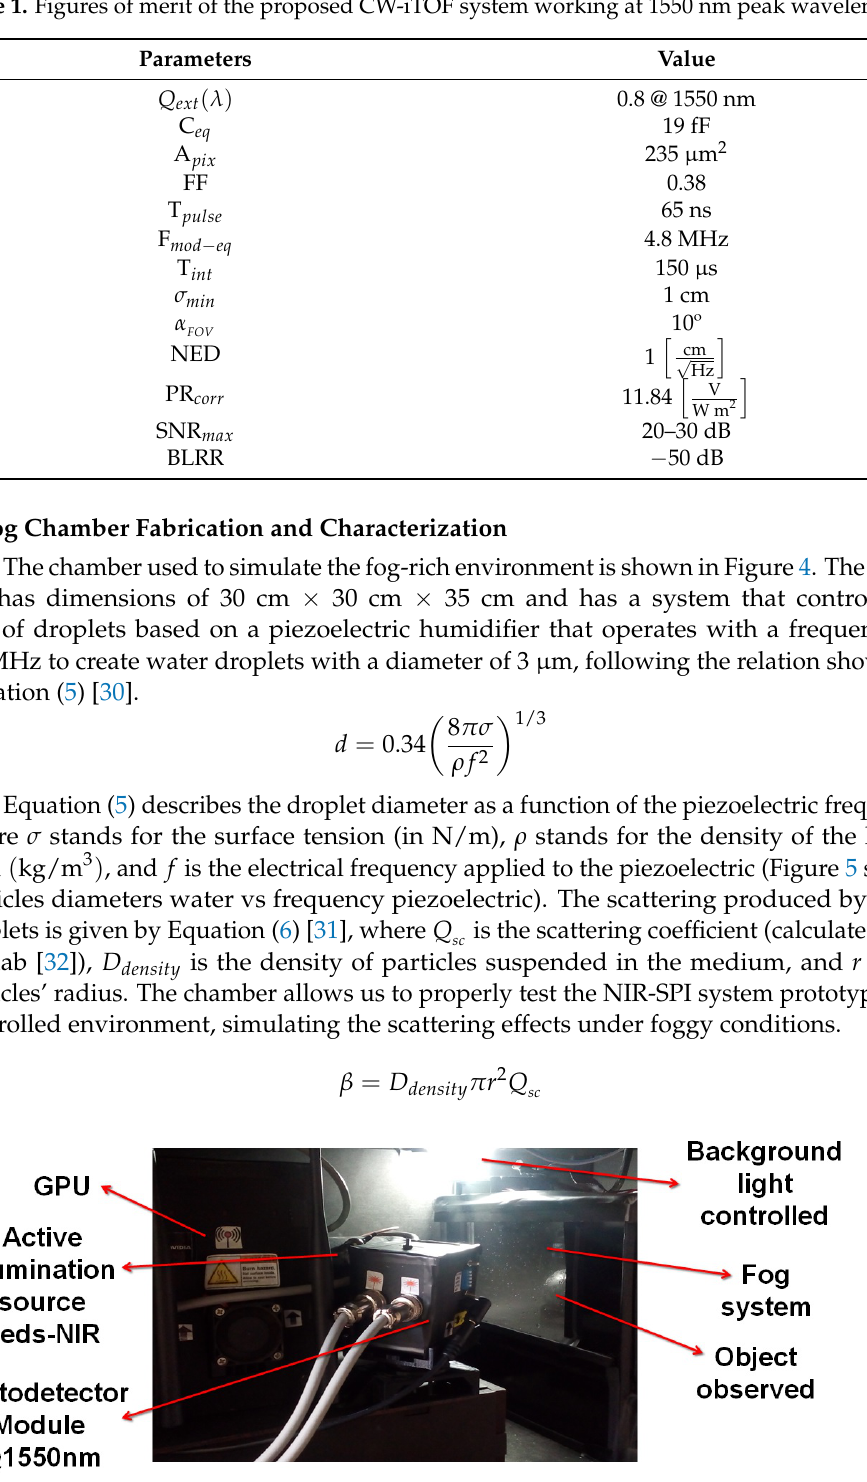
Table 1. Figures of merit of the proposed CW-iTOF system working at 1550 nm peak wavelength.